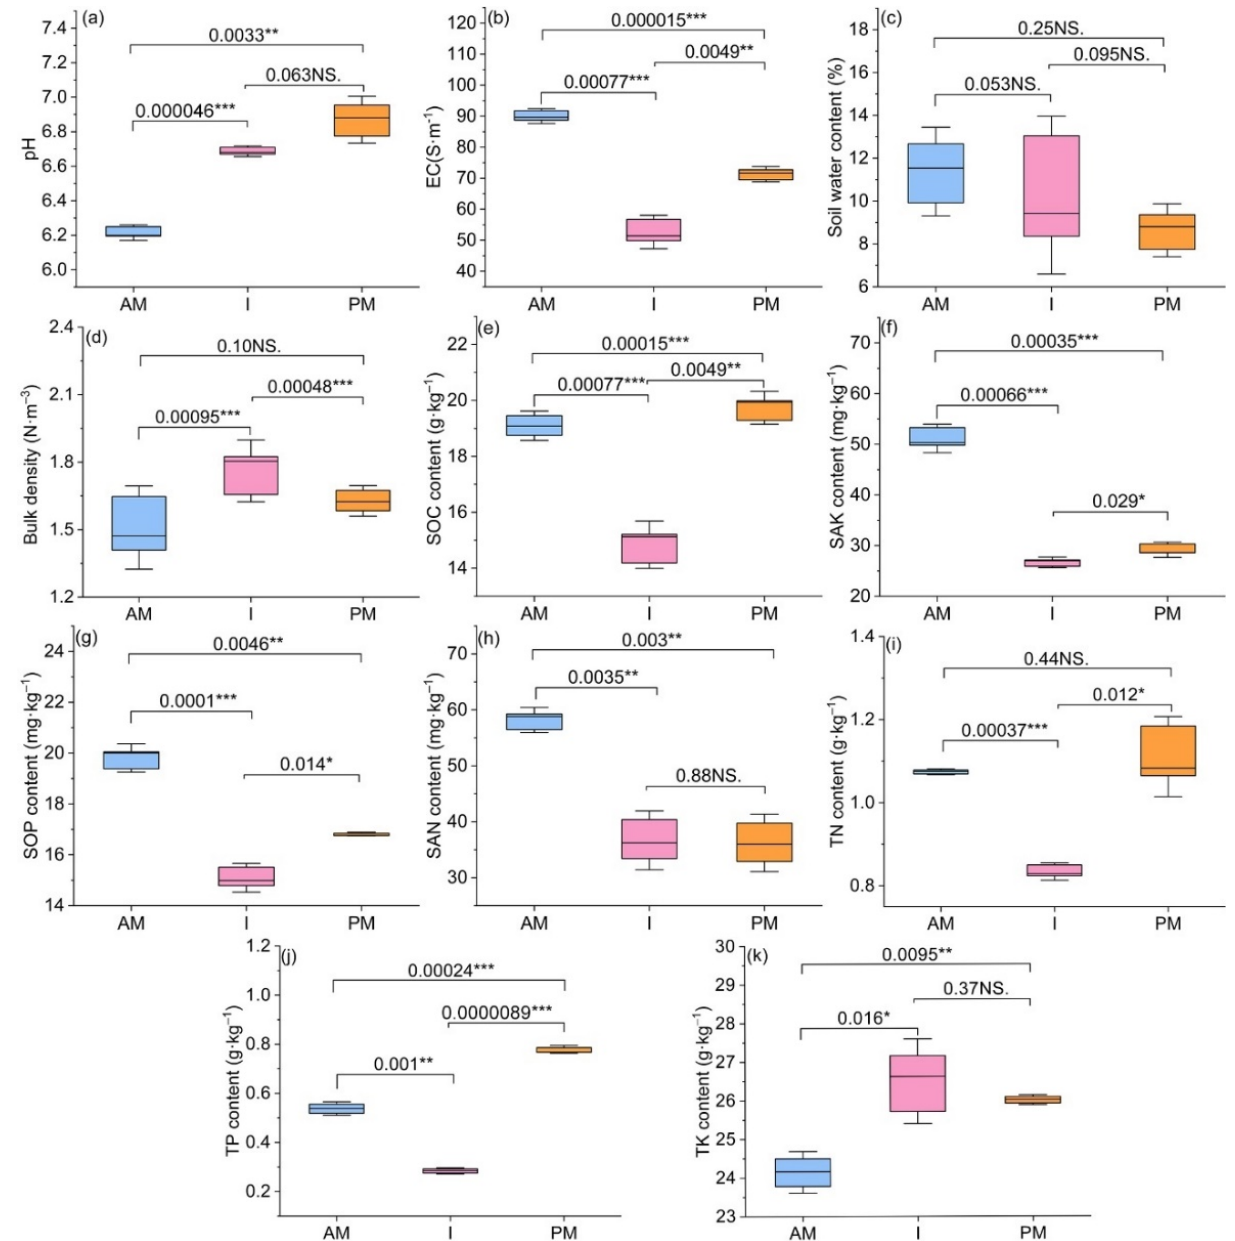
Figure 1. Soil properties under different cropping patterns (n = 9). Different letters indicate signifi- cant differences (ANOVA, p < 0.05, and Tukey’s HSD post hoc analysis) among different intercrop- ping patterns. * is significant at the 0.05 level; ** is significant at the 0.01 level; and *** is significant at the 0.001 level. AM represents areca nut monocropping; I represents areca nut intercropping with pandan; and PM represents pandan monocropping. Different lowercase letters indicate significant differences between treatments under the same index ( p < 0.05). Note: a-pH, b-EC, c-SWC, d-BD, e- SOC, f-,SAK g-SOP, h-SAN, i-TN, j-TP, k-TK.